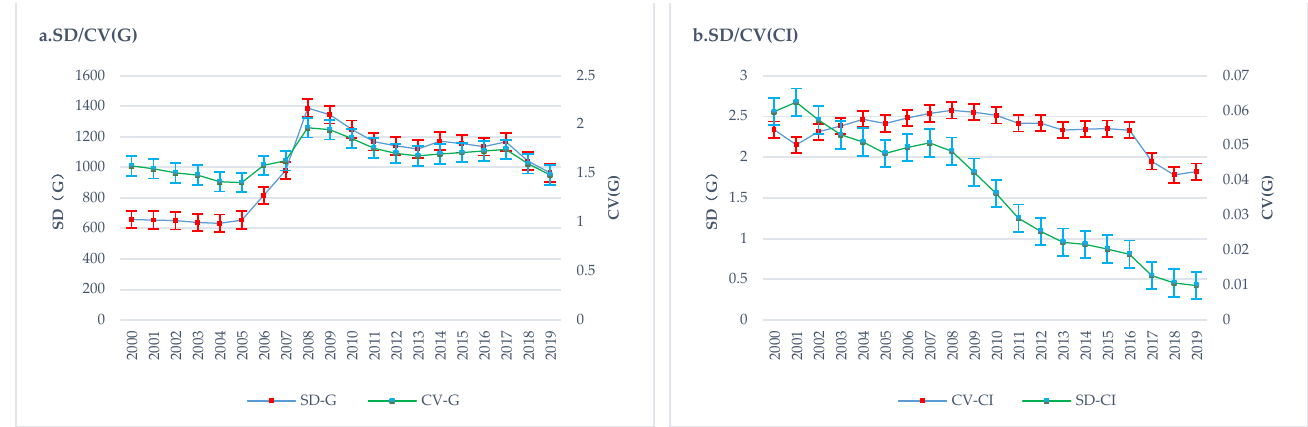
Figure 7. Variations in ( a ) SD/CV(G), representing the standard deviation (coefficient of variation) of the total agricultural GHG emissions”, ( b ) Standard deviation (coefficient of variation) of the agricultural GHG emissions intensity in the Main Stream area of the Yellow River Basin in the Gansu section.